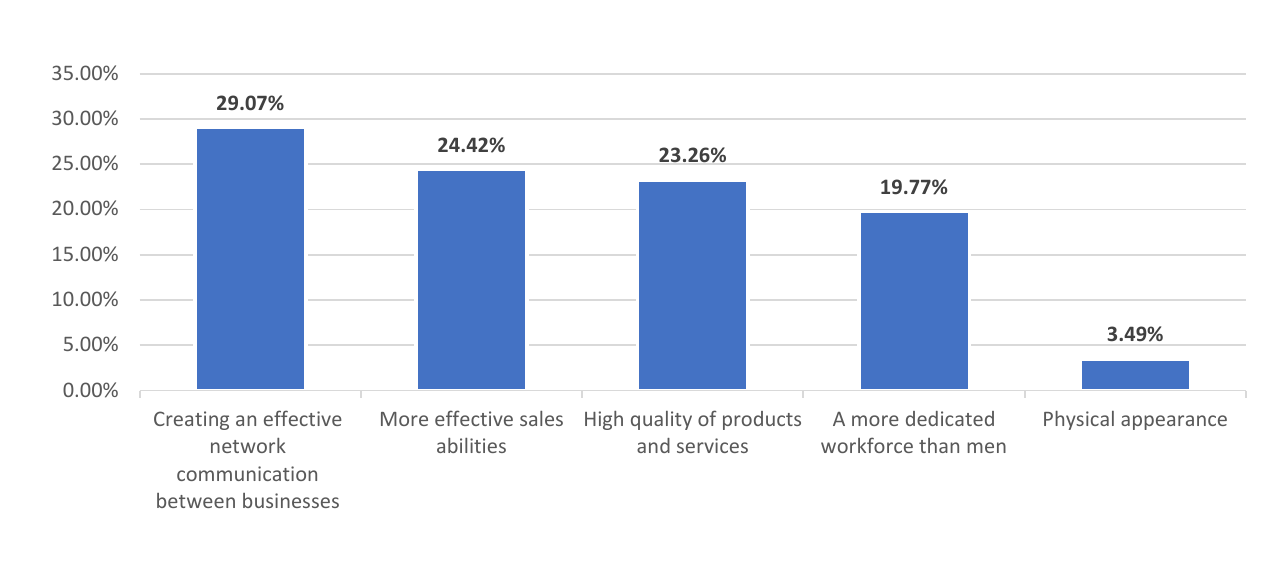
Figure 4. Factors a ff ecting businesses performance (N=36). Source: authors(cid:31) own elaboration. Figure 4. Factors affecting businesses performance (N=36). Source: authors’ own